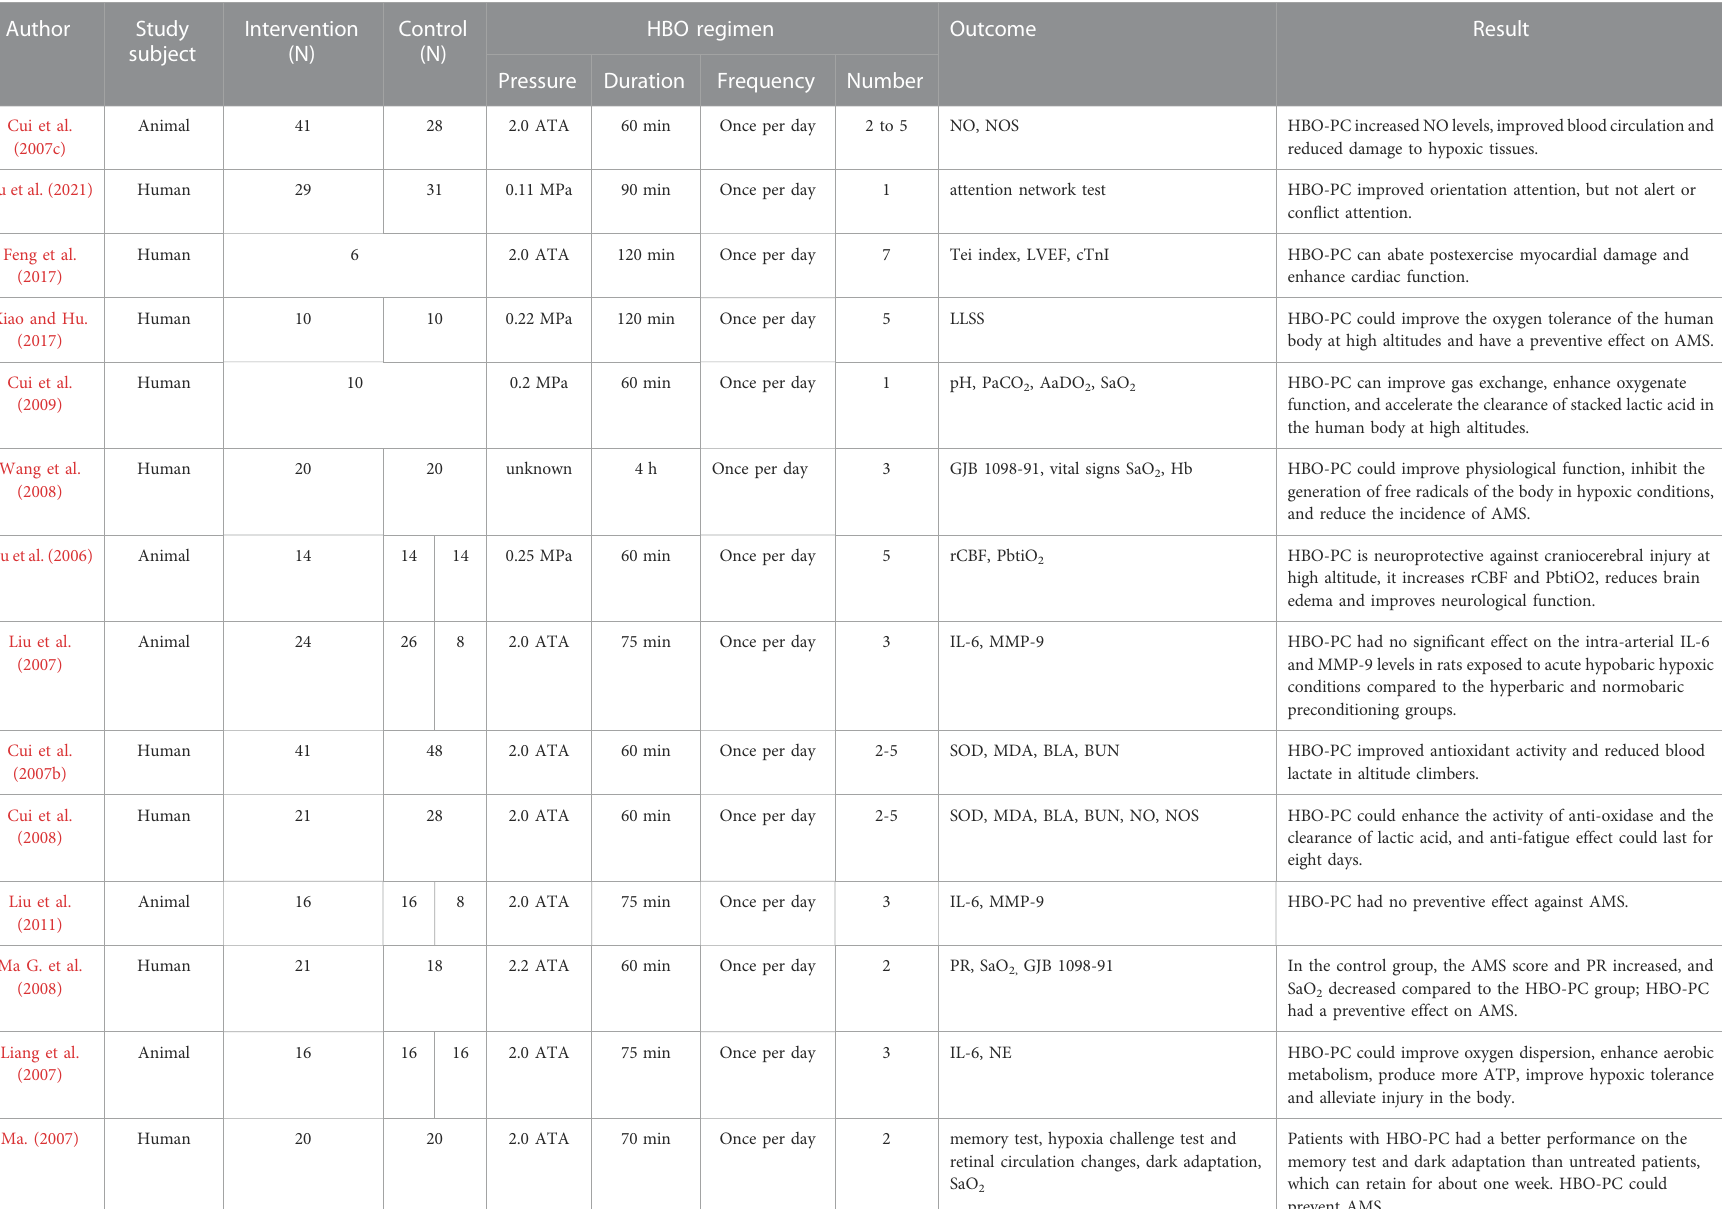
TABLE 1 Studies on hyperbaric oxygen preconditioning in preventing acute high-altitude